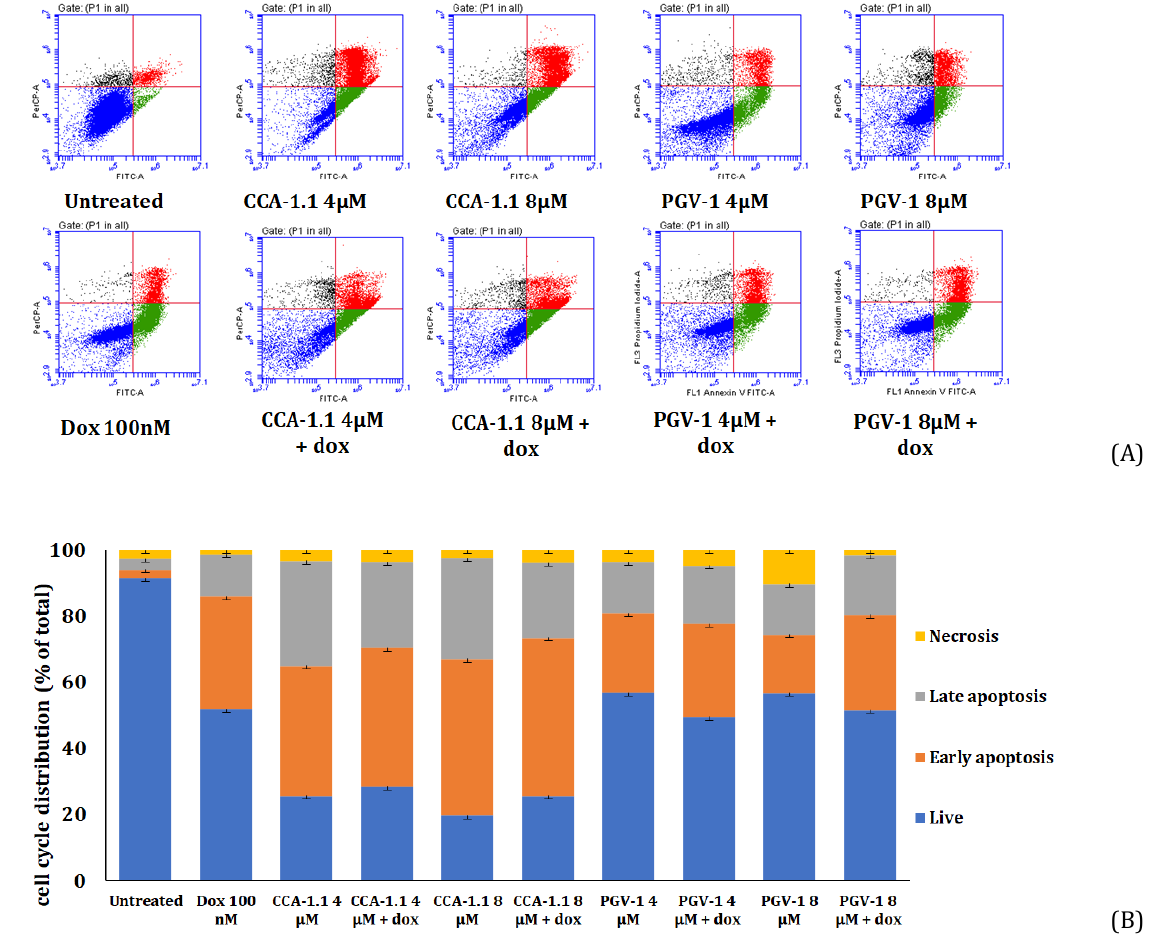
Figure 4. Effects of CCA-1.1, PGV-1, and its combination with doxorubicin (Dox)-induced apoptosis on T47D cells. Cells (2 × 10 5 cells/mL) were incubated with CCA-1.1 and PGV-1 at a concentration of 4 or 8  M for 24 h and then stained with annexin-V–PI. (a) Flow cytograms of each treatment. (b) Quantification of % apoptotic cells. The data are presented as mean ± standard deviation ( n =